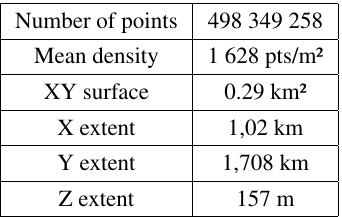
Table 2. Point clouds specifications.